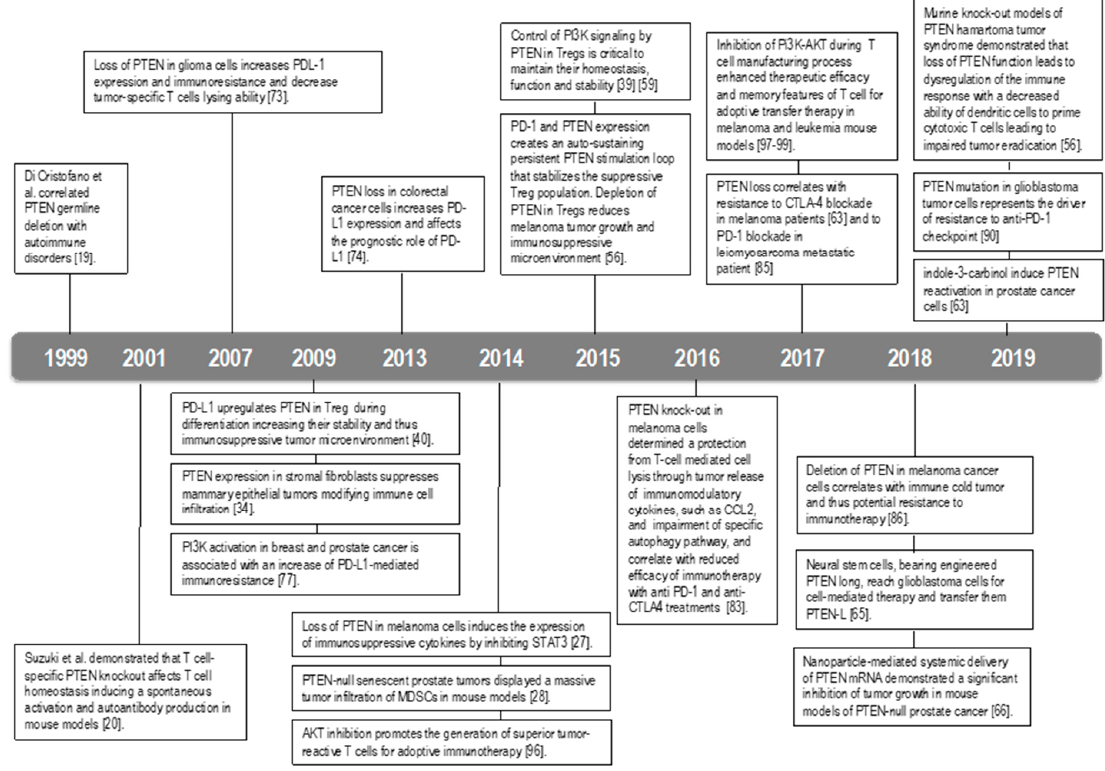
Figure 3. Timeline of the principal findings on PTEN role in immunity.